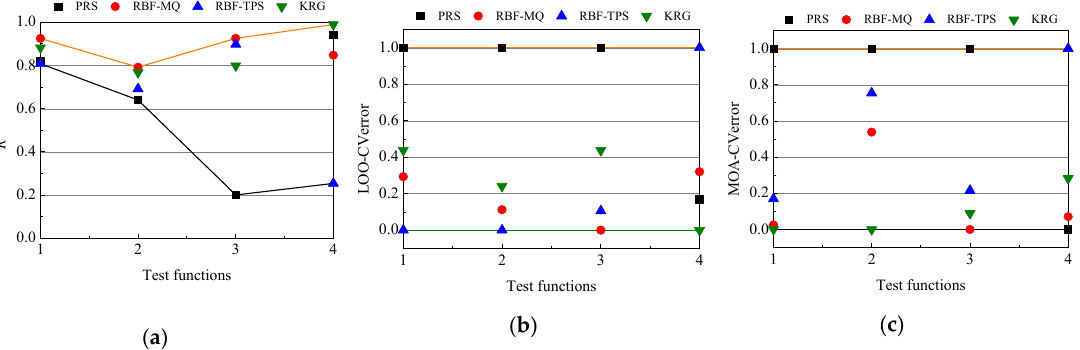
Figure 4. Model ranks by mean of ( a ) R 2 , ( b ) LOO-CVerror and ( c ) MOA-CVerror with 5 n sample points.